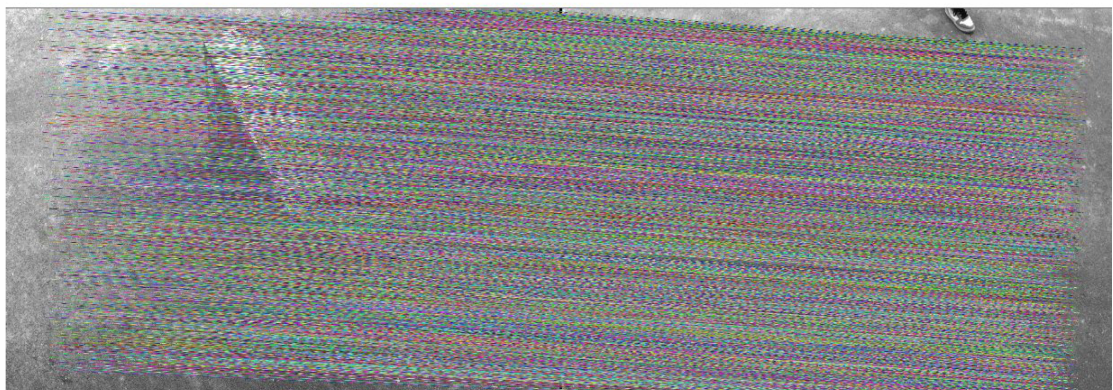
Figure 5. Image 1 matching numbers based on gridding